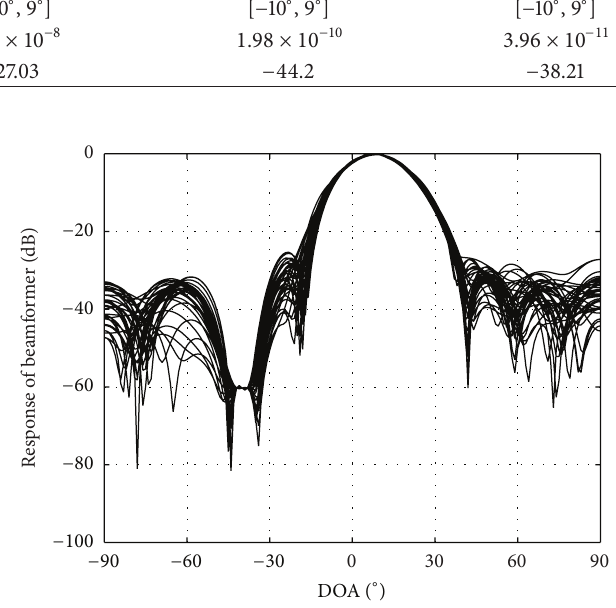
Figure 4: Response of beamformer with proposed method 1.